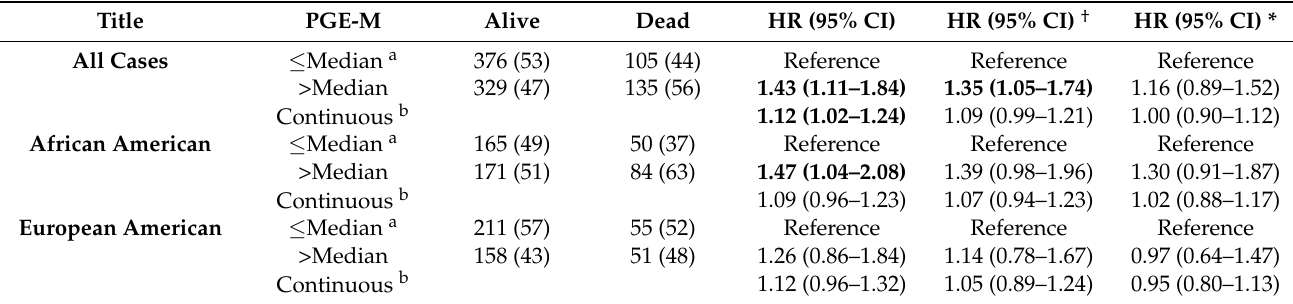
Table 3. Association of urinary PGE-M levels with all-cause mortality among prostate cancer patients.